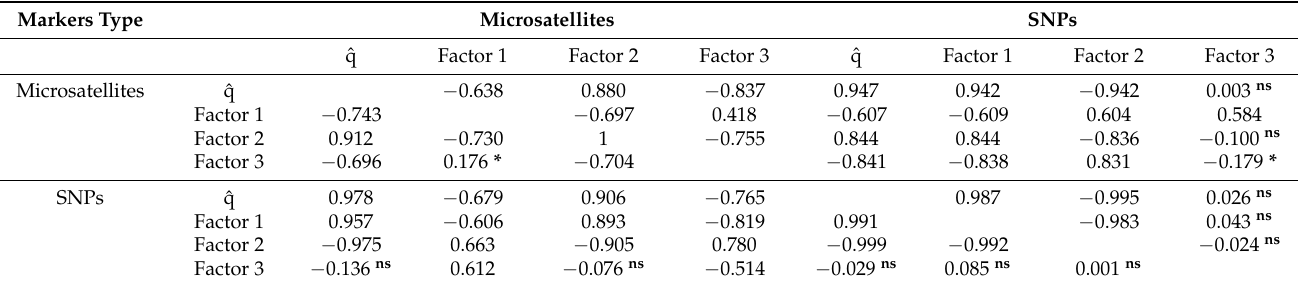
Table 2. Pearson (product-moment; below diagonal) and Spearman (rank; above diagonal) correlation between individual admixture coefficients (ˆq) computed for K = 2 and eigenvectors corresponding to the first three factors retained using PCA using microsatellite and SNP